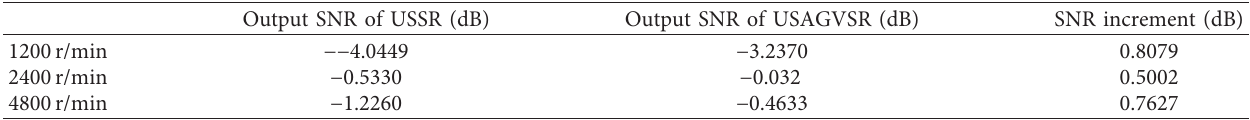
Table 4: Output SNR comparison of different rotation